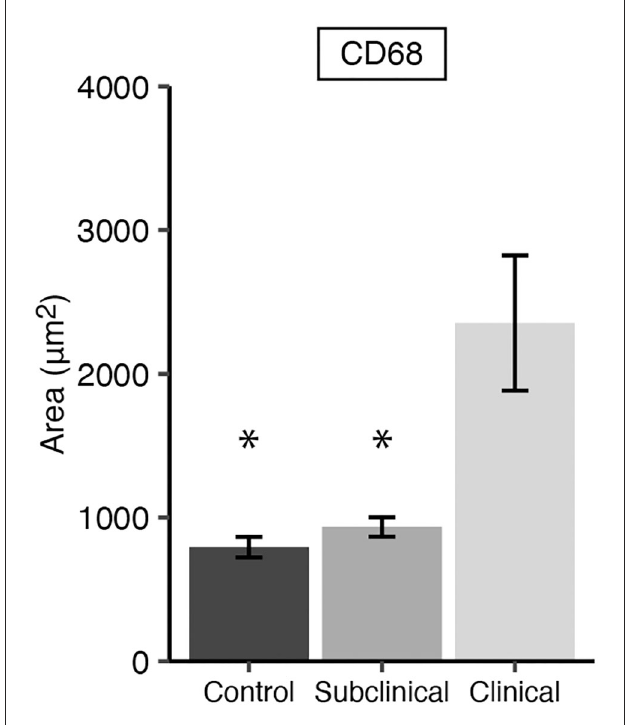
FIGURE1 CD68 expression representing total macrophages present in frozen mid-ileal tissue from dairy cows naturally infected with Mycobacterium avium subsp. paratuberculosis (MAP) (clinical n = 9, subclinical n = 9) or JD- controls ( n = 8). Data are presented as the mean fluorescence area µ m 2 ± SE and significance is indicated as * < 0.05 as compared to the clinical